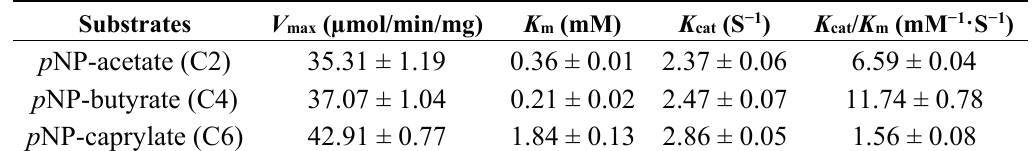
Table 3. Kinetic parameter of HydS14 with difference chain lengths p -nitrophenyl ester.